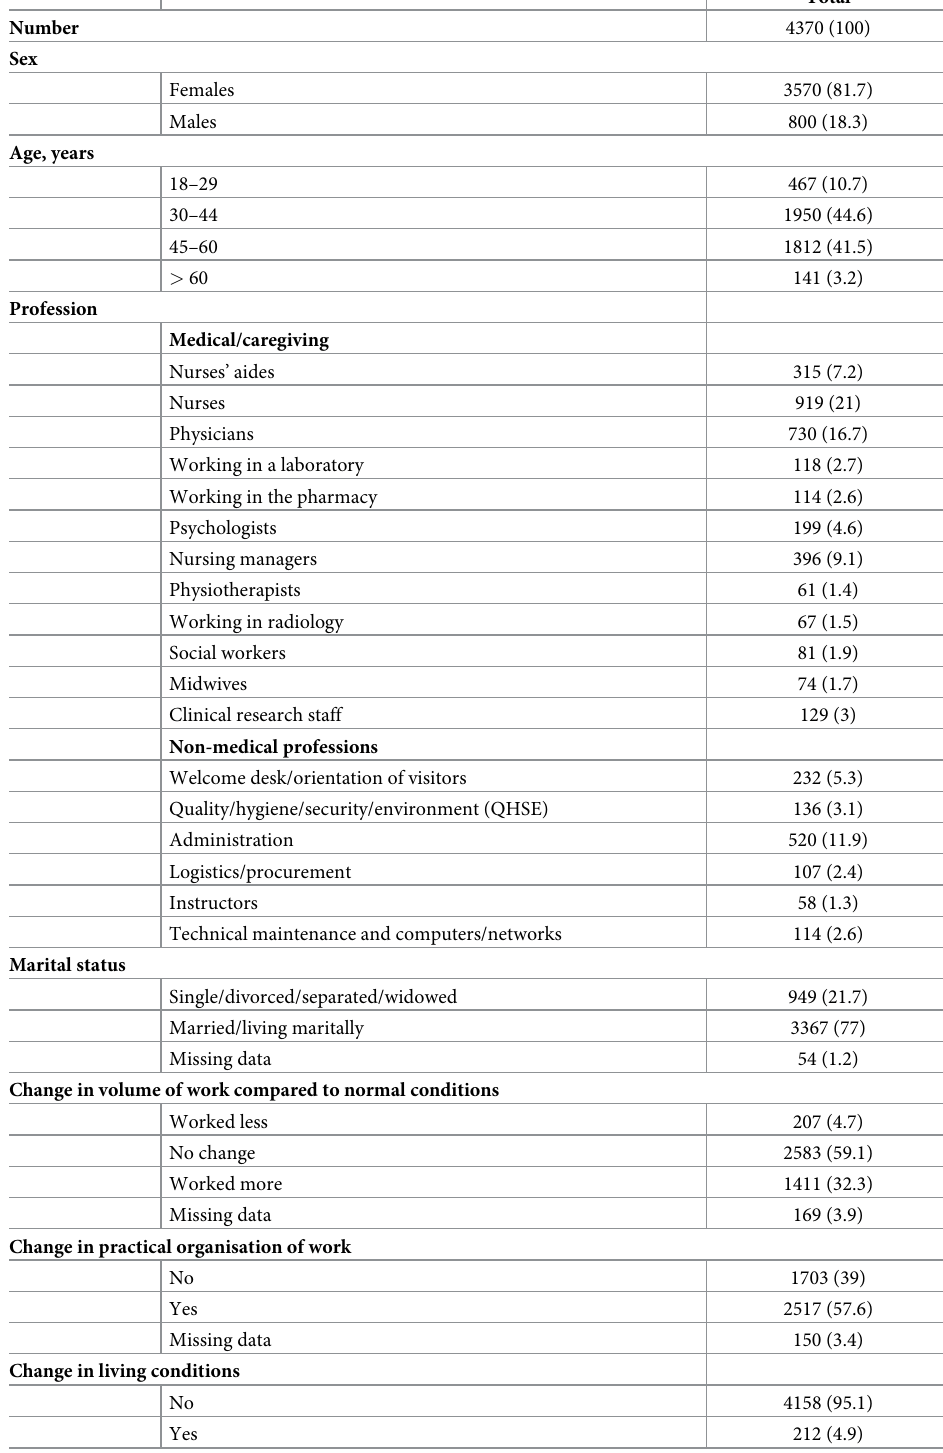
Table 1. Socio-demographic characteristics of the study population—PsyCOVID all professionals study, per- formed from 4 June to 22 September